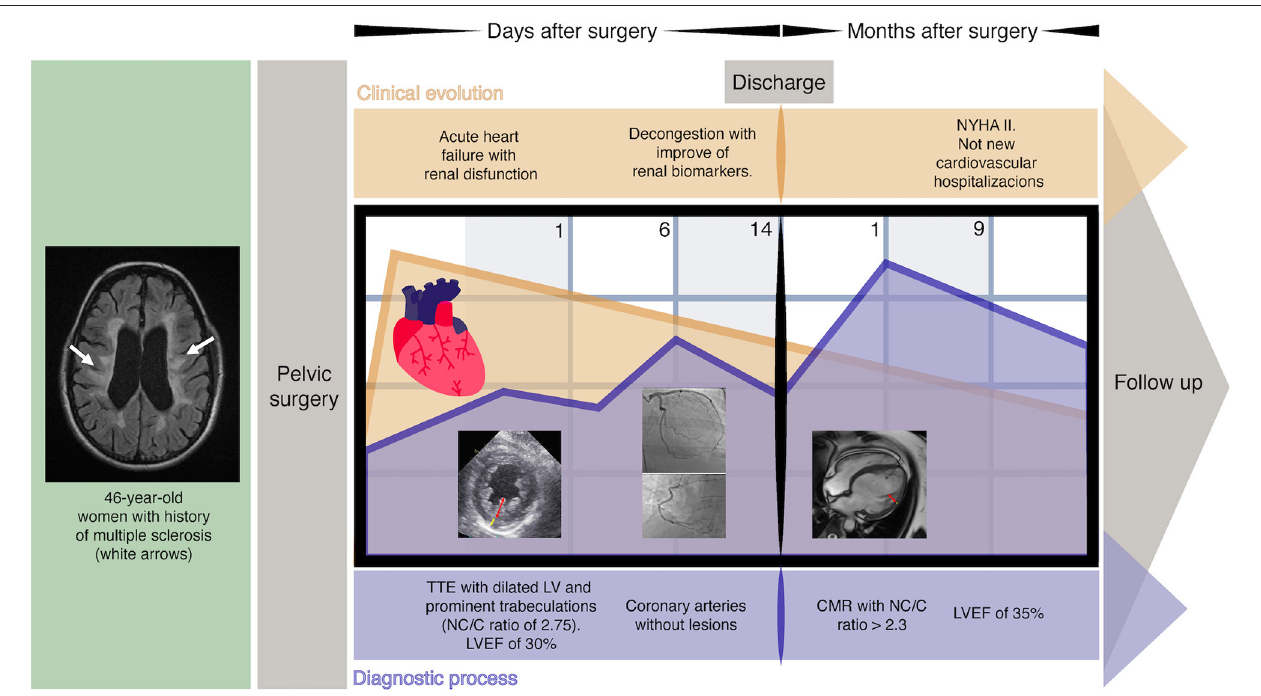
FIGURE 4 | The timeline of events. CMR, cardiac magnetic resonance; LV, left ventricle; LVEF, left ventricular ejection fraction; NC/C, non-compacted to compacted; NYHA, New York Heart Association; TTE, transthoracic echocardiogram.